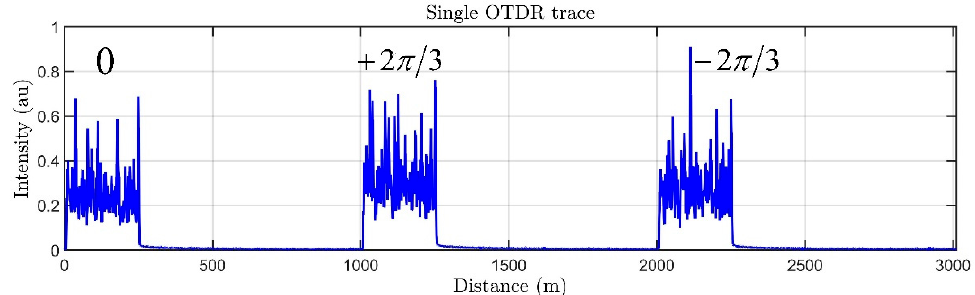
Figure 2. A typical DAS OTDR trace. Three groups corresponding to different phase shifts are shown.